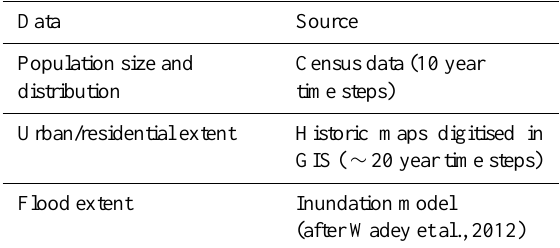
Table 1. Summary of required data and sources.